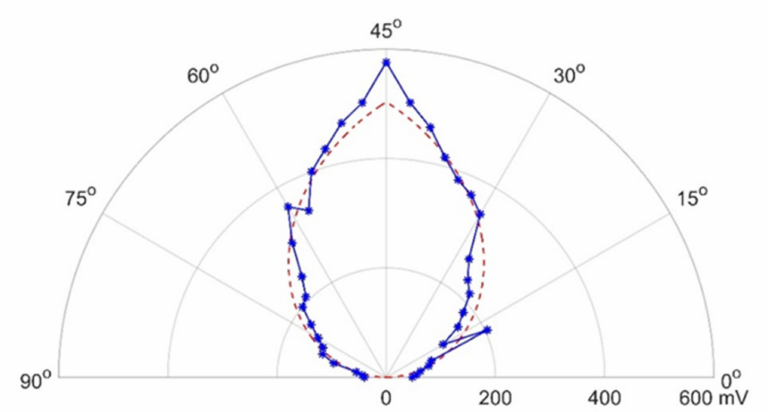
Figure 7. Angular variation of transmitter–receiver